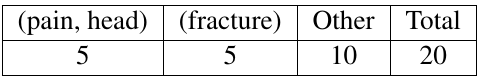
Table 6: Strong matching example